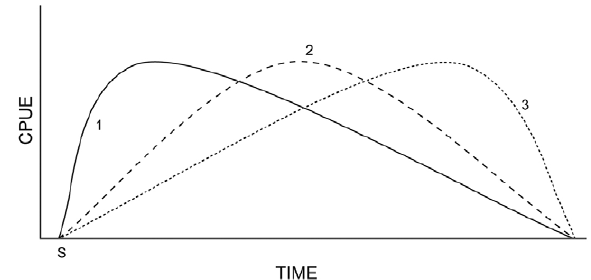
Fig. 2. – Types of rate of CPUE decrease after the peak in a fishing season. 1 slow; 2, medium; 3, fast. S, month in which the fishing